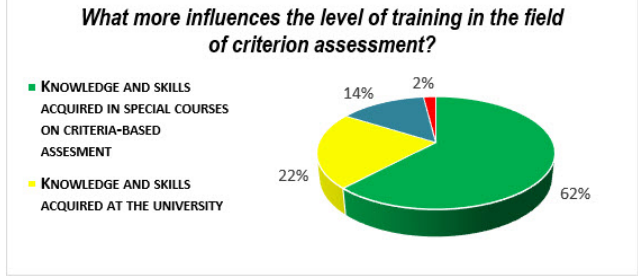
Figure 2. Impact on education in the field of criteria-based assessment